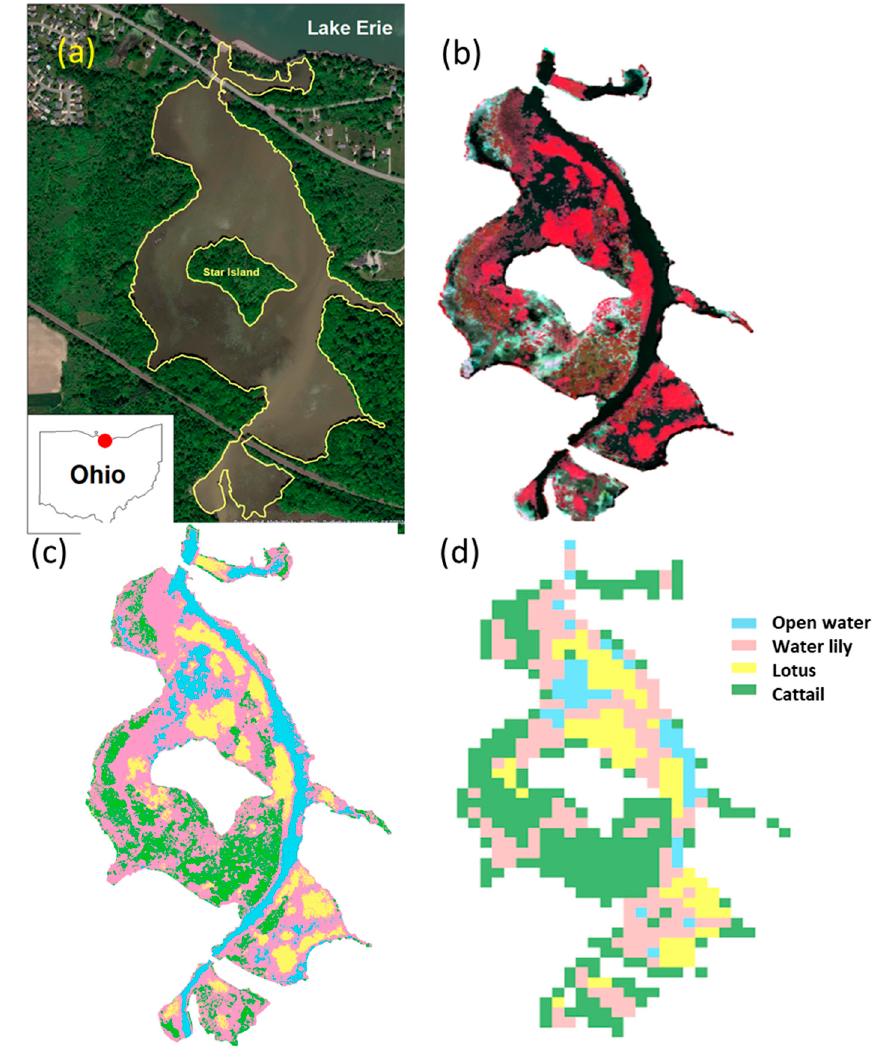
Figure 1. ( a ) The location of our wetland site—Old Woman Creek (OWC) National Estuarine Research Reserve, at the shore of Lake Erie. The boundary of OWC is highlighted in yellow. Star island is located at the center of OWC. The background image is from the imagery basemap in the Esri Arcmap software package. ( b ) The false-color composition (bands 8, 5, and 3 correspond to near-infrared, red, and green, respectively) of WorldView-3 imagery was acquired on 17 August 2017. ( c ) Supervised classification result of WorldView-3 imagery. ( d ) Classification result of the HLS dataset based on the NDVI time series of 2017.